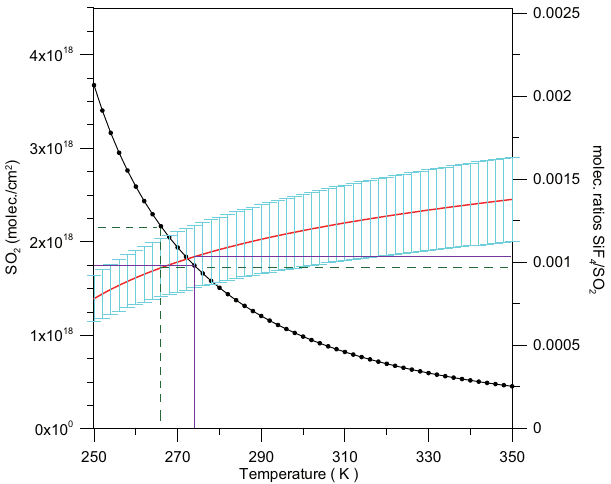
Fig.9. SensitivityoftheretrievedSO 2 columntotheestimatedplumetemperature(blackpoints). Theredline Fig. 9. Sensitivity of the retrieved SO 2 column to the estimated shows the resulting SiF 4 /SO 2 molecular ratios as a function of chosen plume temperature. The ratios and its plume temperature (black points). The red line shows the resulting errorareobtainedfromtheslopeofthelinearfitsofsixthermalemissionspectratakenat0.5cm − 1 resolution SiF 4 /SO 2 molecular ratios as a function of chosen plume temper- nearthemoonandbetweenthelunarmeasurements(see. Figures7and8) ature. The ratios and its error are obtained from the slope of the linear fits of six thermal emission spectra taken at 0.5cm − 1 res- olution near the moon and between the lunar measurements (see, Figs. 7 and 8)